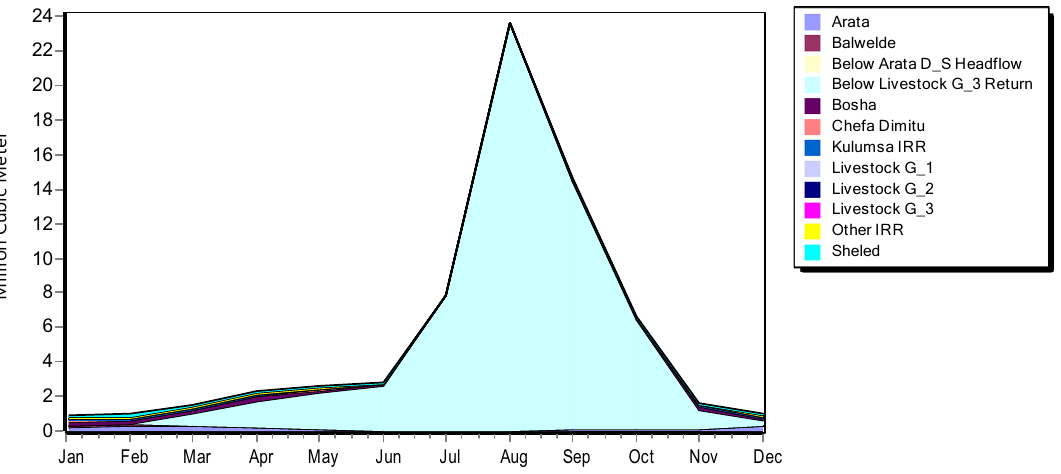
Fig. 14 Environmental flow in Arata